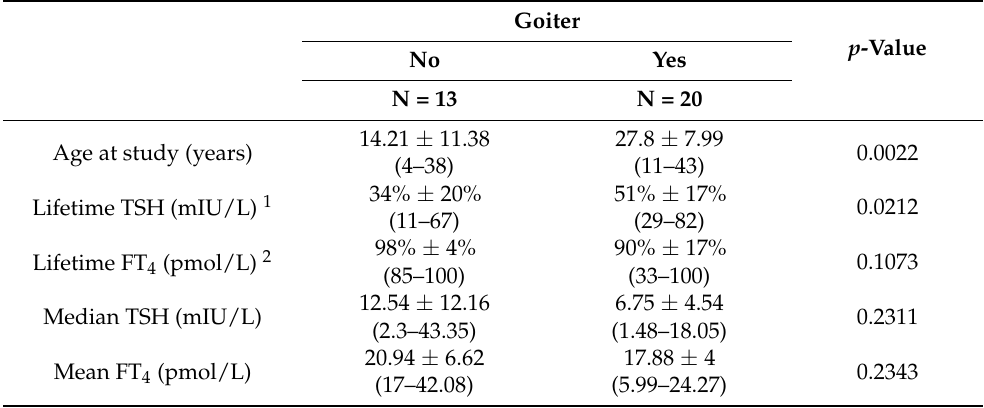
Table 4. Comparison of thyroid function parameters between patients that developed goiter and patients without